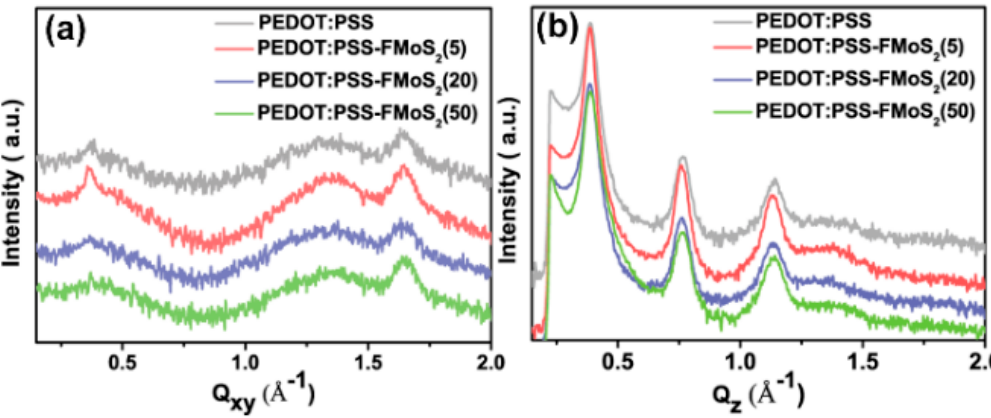
Figure 5. ( a ) In-plane and ( b ) out-of-plane spectra of poly(3 - hexylthiophene):[6,6]-phenyl-C61-butyric acid methyl ester thin films deposited on poly (3,4-ethylendioxythiophene): poly(styrenesulfonate) (PEDOT:PSS) and PEDOT:PSS combined with 5, 20, and 50 µL of oleylamine-functionalized MoS 2 samples obtained from grazing-incidence wide-angle X-ray scattering.